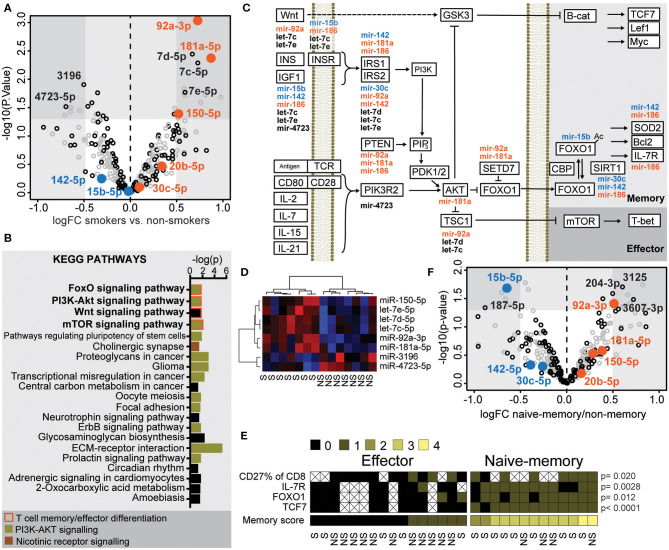
microRNAs differentially expressed in smokers regulate the PI3K-AKT-FOXO signaling pathway. Isolated CD8+ T cells from human peripheral blood were activated with 30 nM PMA and 500 nM ionomycin for 2 h. (A) Fold change of miR expression in smokers compared to non-smokers. MiRs with complete data are included; those exceeding an average microarray signal intensity of 80 are presented in black. MiRs included in further analyses are highlighted in color orange and blue for up- or downregulated, respectively. (B) Kegg pathways that involve the miRs that were significantly down- or upregulated in smokers. Pathways of T cell effector/memory differentiation, PI3K-AKT signaling or nicotine signaling are indicated by color as indicated with color key. (C) A graphic map of the Kegg pathways indicated with bold in (B). MiRs predicted to inhibit expression of proteins involved in these pathways are placed adjacent to the protein. (D) Heatmap and clustering of miRs differentially expressed in smokers. Clustering was based on Ward's minimum clustering method and distances were calculated with Spearman correlations. (E) A scoring system was constructed to differentiate between naïve-memory and effector phenotype. A frequency of CD27+CD8+ cells above the median of all samples, or a higher than median expression of IL7R, FOXO1, or TCF7 mRNA were rewarded with one point each. Samples with at least two points were considered to have a naïve-memory phenotype. P-values between the two groups were calculated with the Mann-Whitney U-test. The smoking status of each individual is indicated below. (F) Volcano plot of the fold change of miRs in samples with naïve-memory vs. effector phenotype according to the scoring system in (E). S, smoker; NS, non-smoker. An X indicates missing data.